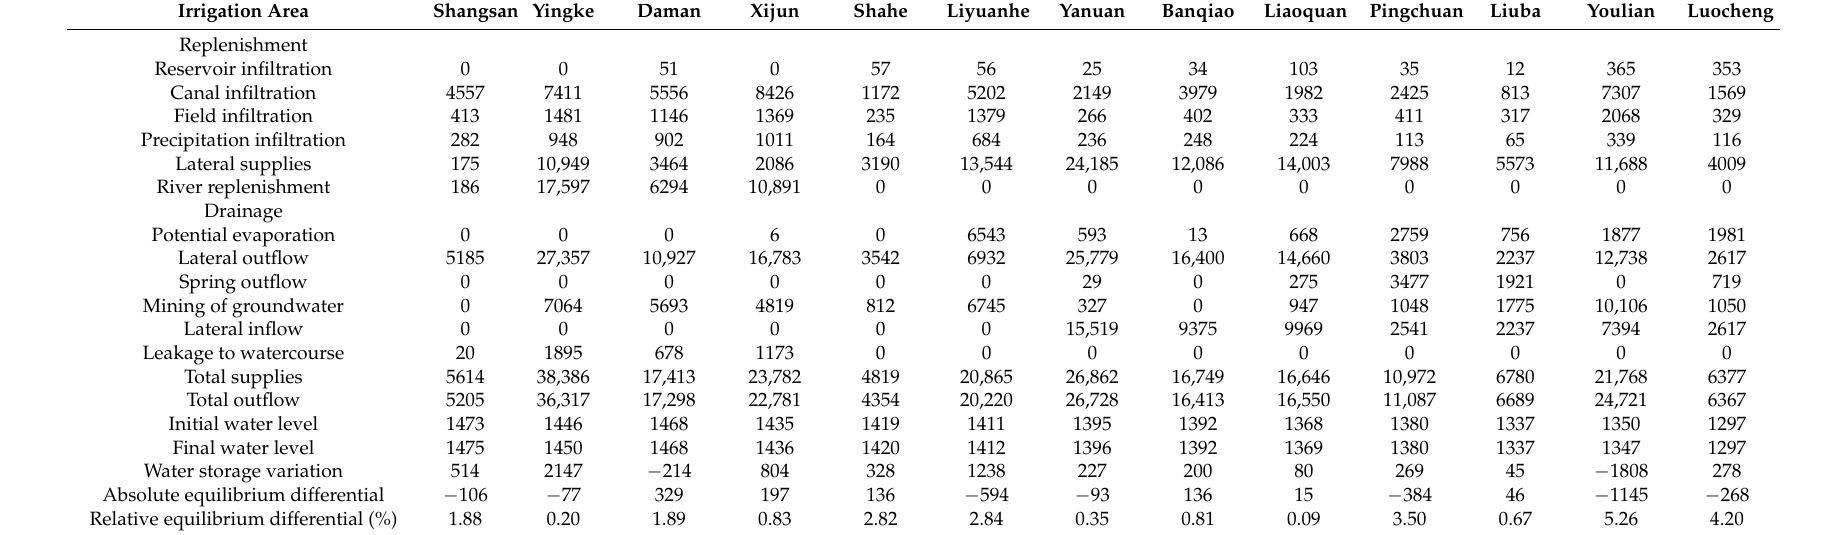
Table 2. Verification table of the groundwater equilibrium in the irrigation area; unit: 10 4 m 3